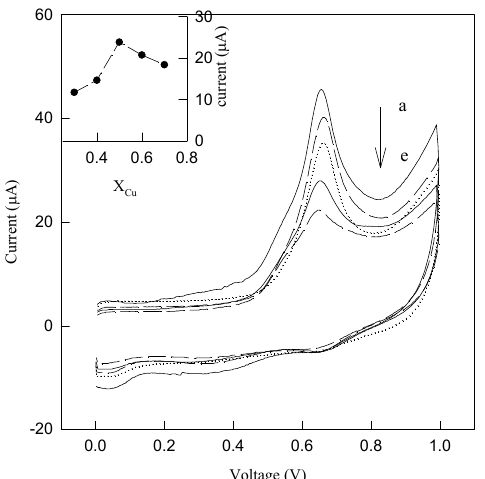
Figure. 6 Effect of the ratio of Cu(II) and Co(II) in the electrodeposited solution on the catalytic ability of tryptophan. KCl: 0.5 M; K